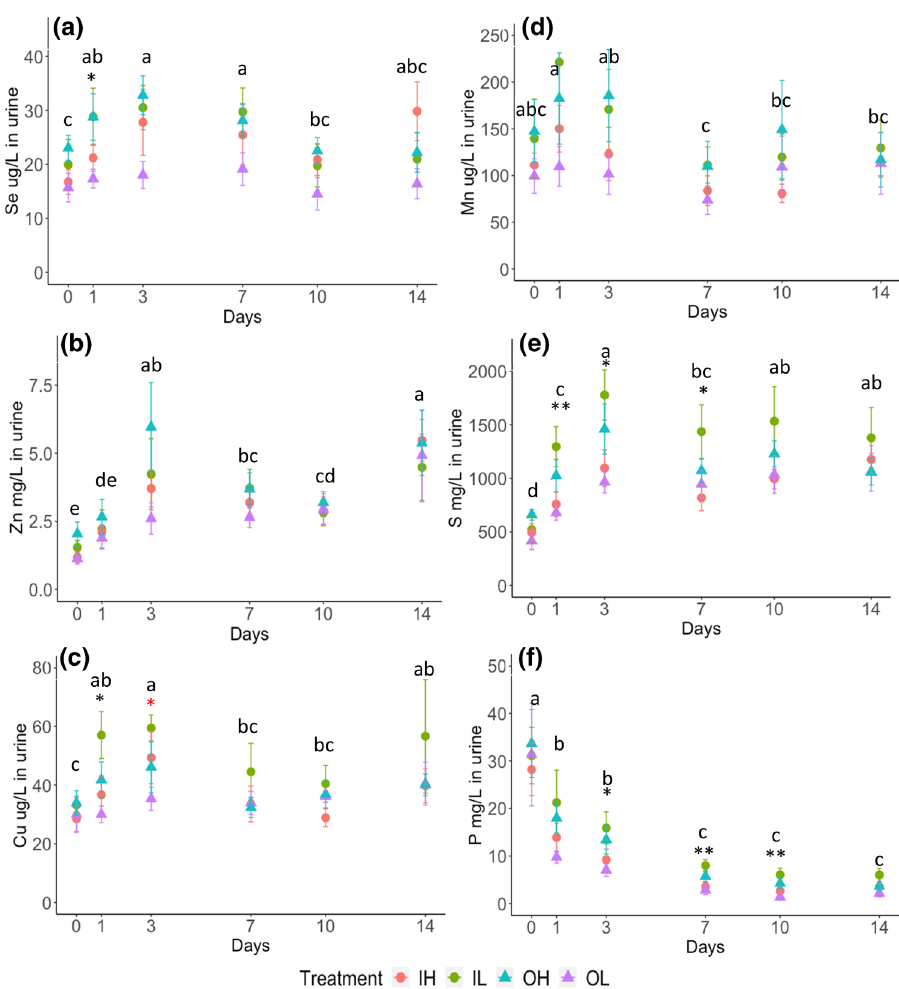
Figure 3. The concentrations of micronutrients and macronutrients in the urine of sheep during the supplementary period. ( a ) Se (μg L −1 ) in urine ( b ) Zn (mg L −1 ) in urine ( c ) Cu (μg L −1 ) in urine ( d ) Mn (μg L −1 ) in urine ( e ) S (mg L −1 ) in urine ( f ) P (mg L −1 ) in urine. The error bars are the standard errors (n = 6) of the samples. The colour of the symbol: ‘ * ’, ‘ * ’, ‘*’ represents the significant effect from supplement form (F1), supplementary dose (F2), the interaction of F1 and F2, respectively. The number of starts ‘*’ and ‘**’ indicate statistical significances of ANOVA test at p-value < 0.05 and < 0.01, respectively. The lowercase English letters represent the statistical results of post-hoc LSD test of temporal effect following a significant result of ANOVA